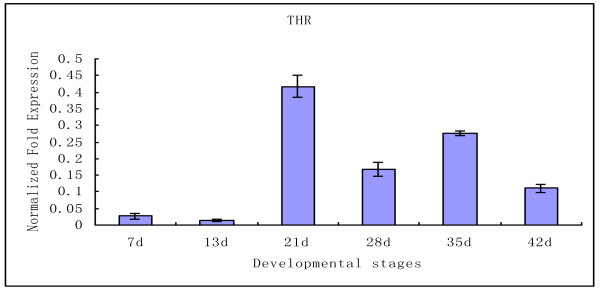
mRNA expression of SjTHRβ inS. japonicumby real-time quantitative PCR. Data were normalized against the amplified internal housekeeping control gene SjNADH. Worms were collected from infected rabbits at day (d) 7, 13, 21, 28, 35 and 42 days post-infection. This result was obtained by three separate assays with identical protocols. Vertical bars denote the ± SD about the mean.